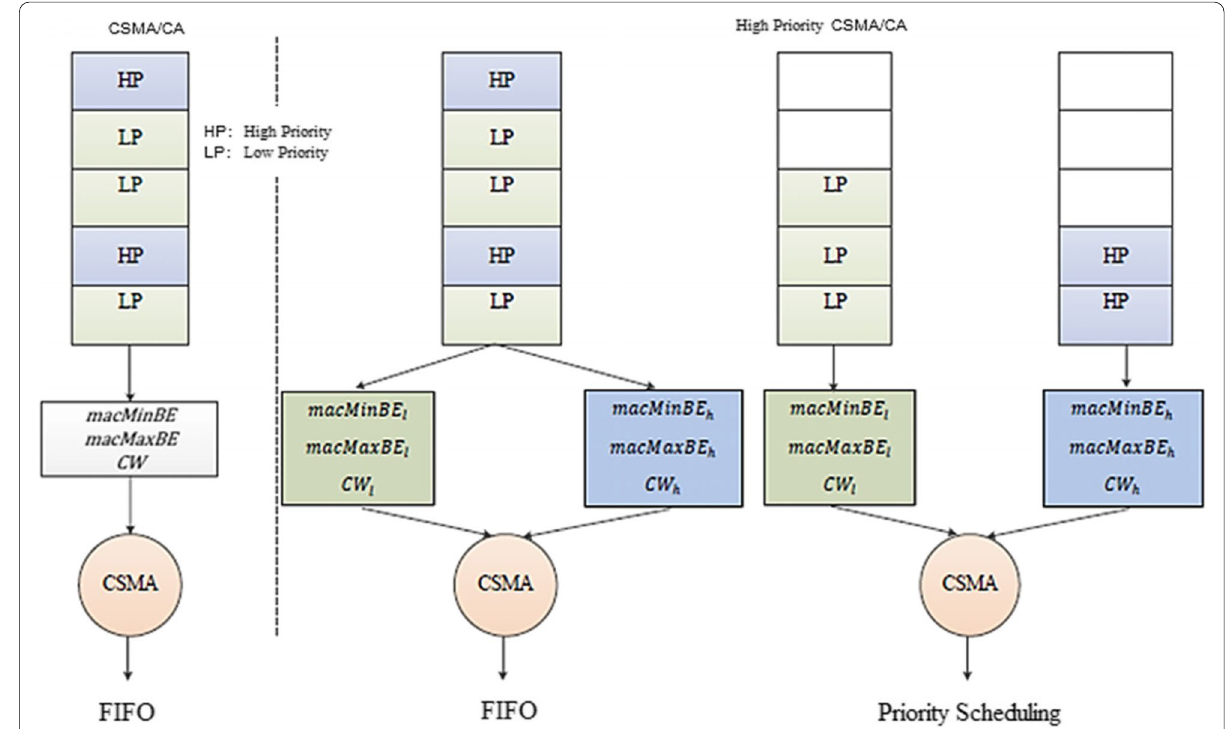
Fig. 4 CSMA/CA FIFO scheduling and priority